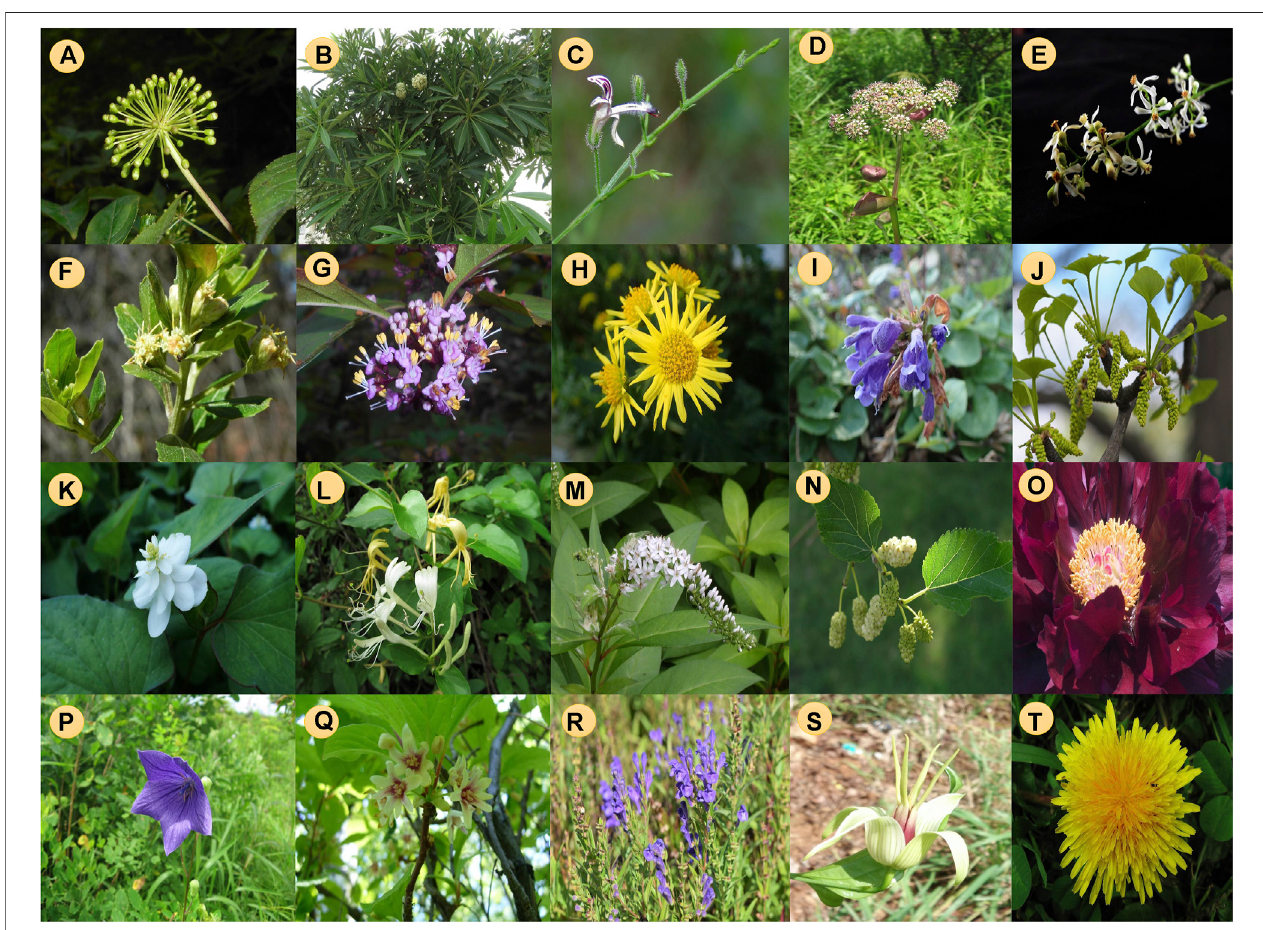
FIGURE 1 | Medicinal plants investigated against COPD. (A) Eleutherococcus senticosus (= Acanthopanax senticosus), (B) Alstonia scholaris, (C) Andrographis paniculata, (D) Angelica decursiva, (E) Azadirachta indica, (F) Baccharis retusa, (G) Callicarpa japonica, (H) Chrysanthemum indicum, (I) Dracocephalum rupestre, (J) Ginkgo biloba, (K) Houttuynia cordata, (L) Lonicera japonica, (M) Lysimachia clethroides, (N) Morus alba, (O) Paeonia × suffruticosa, (P) Platycodon grandi fl orum, (Q) Schisandra chinensis, (R) Scutellaria baicalensis, (S) Stemona tuberosa, (T) Taraxacum campylodes (= T. of fi cinale).